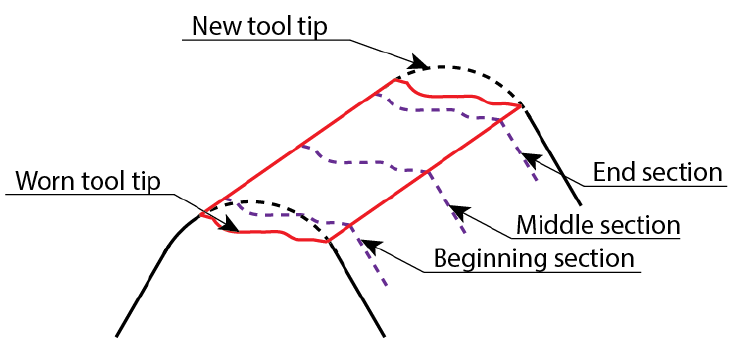
Figure 4. Schematic draw of new and worn tools and selected sections for wear analysis.